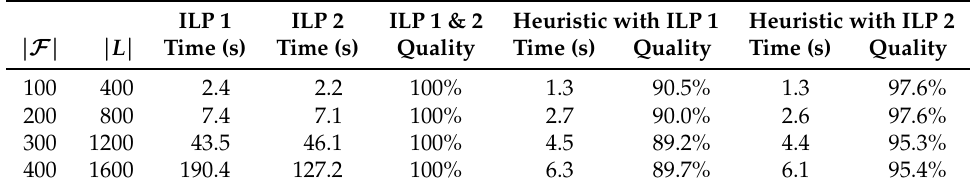
Table 2. Experimental results with the same setting as in Table 1, except that this time every square of size 2 × 2 was required to intersect at most two